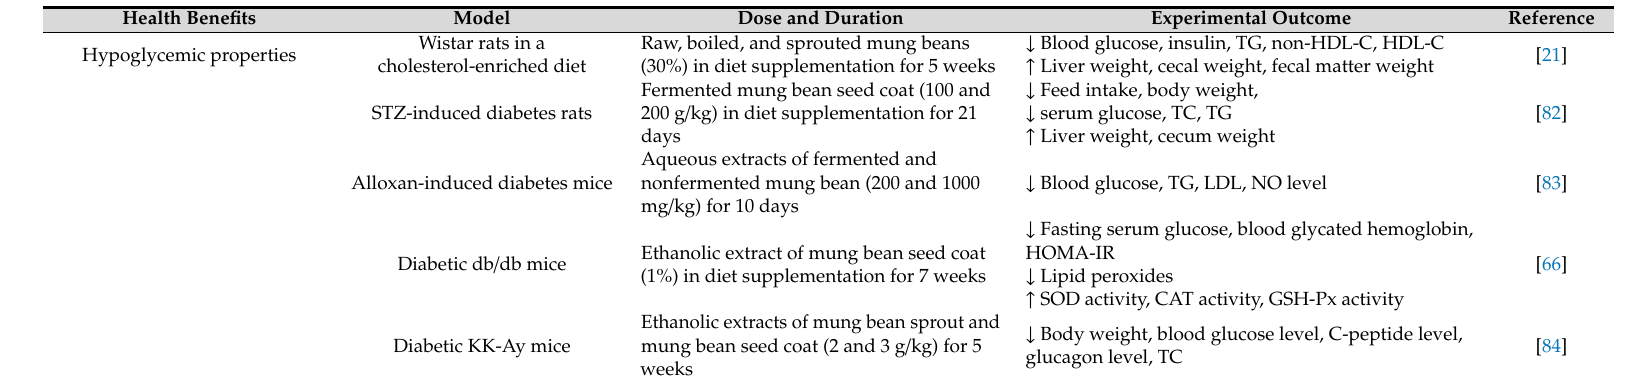
Table 4. Animal studies on the mung bean and its active compounds in health